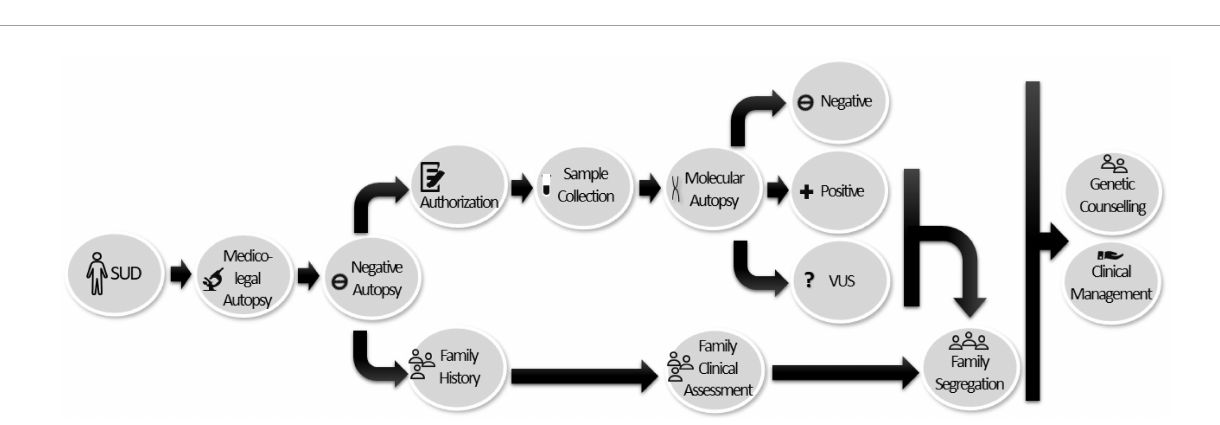
FIGURE4 Workflow diagram for the multidisciplinary team and the implementation of molecular autopsies in SUD cases. Once sudden death has been reported, a complete forensic autopsy is performed. In cases in which the result is negative or non-conclusive, it is recommended that a tissue sample be obtained and preserved for molecular study (with prior authorization, based on the legislation in force in each country). If the genetic study is positive or variants of uncertain significance are identified (due to lack of available information), segregation of the victim’s relatives should be carried out to clarify the role of VUS and to identify at-risk family members. Genetic counseling and appropriate clinical management should be provided to the victim’s